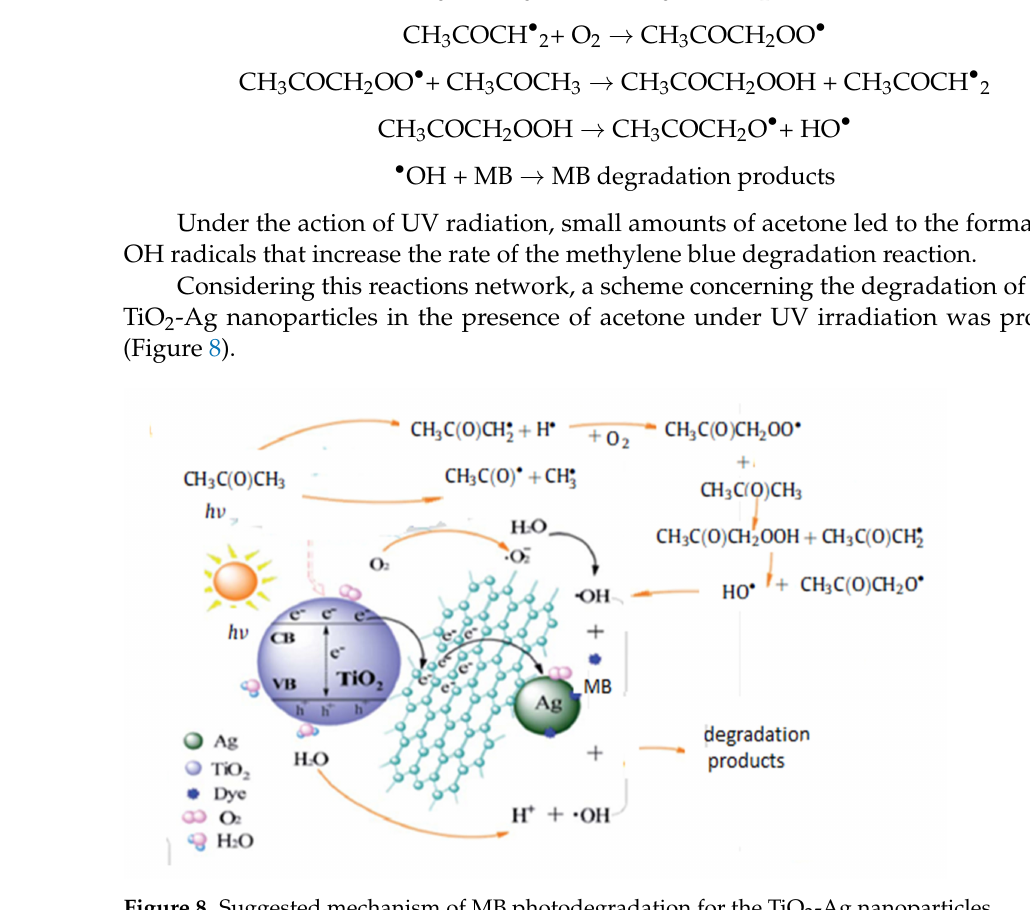
Figure 8. Suggested mechanism of MB photodegradation for the TiO 2 -Ag